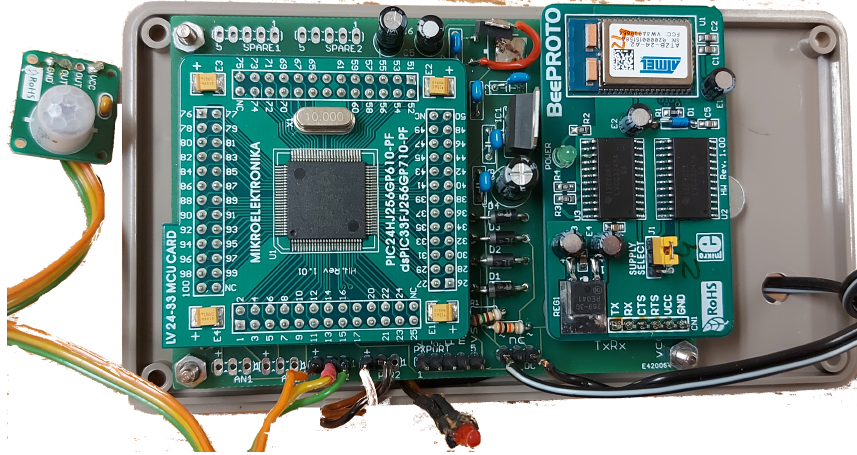
Figure 1. The electronics of the PIR sensor as installed in the